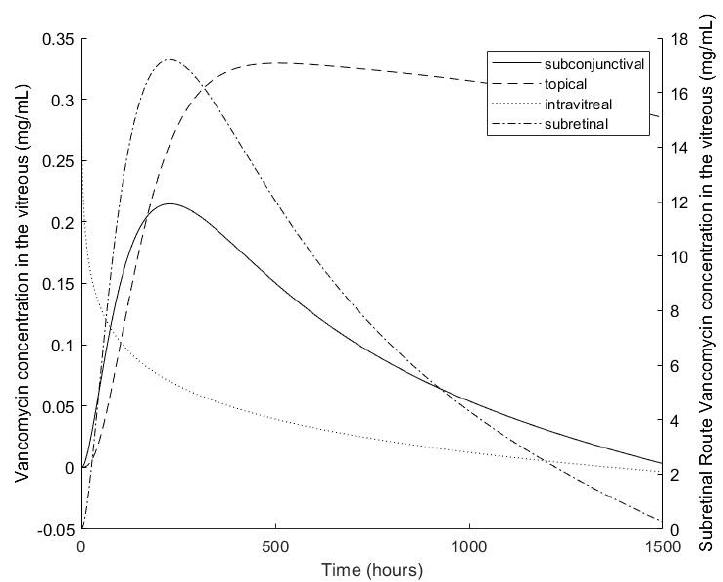
Figure 7. Vancomycin concentration in the vitreous over 1500 h as predicted by compartment mod-